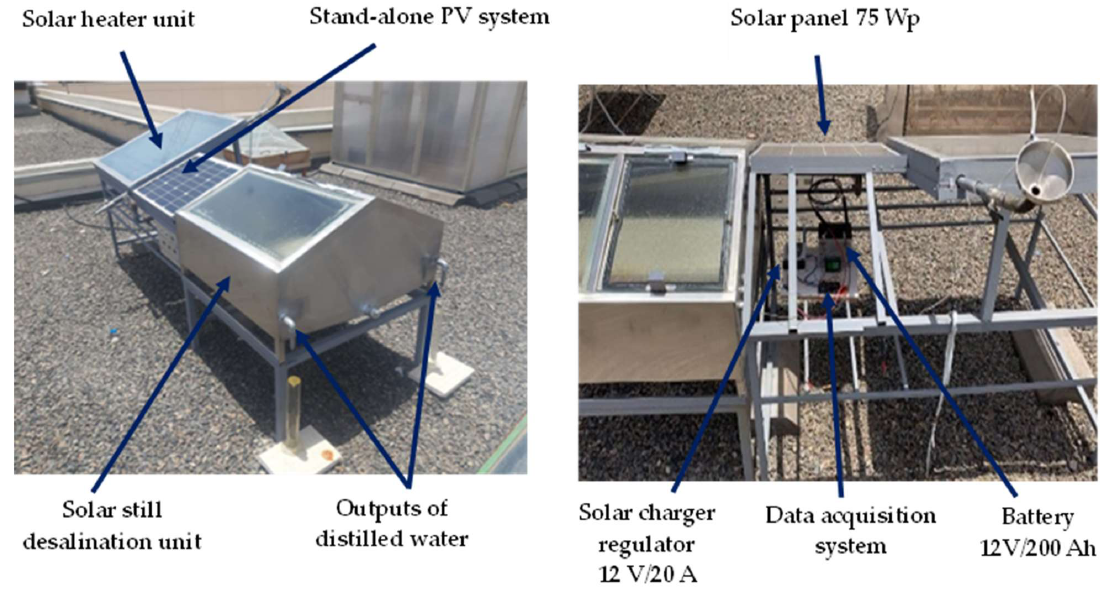
Figure 7. A photo of the solar desalination unit powered by stand-alone PV system (roof of the Faculty of Science building at IU, Madinah, KSA).